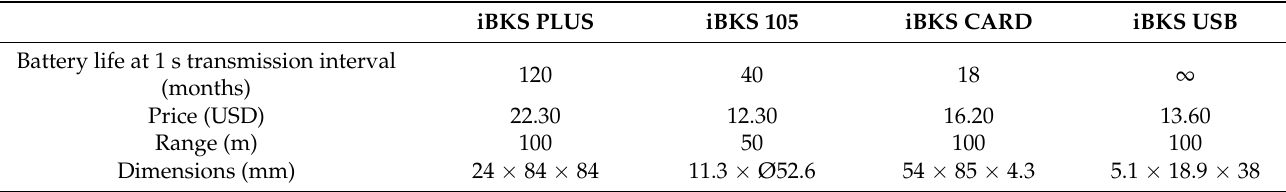
Table 1. Accent Systems beacon